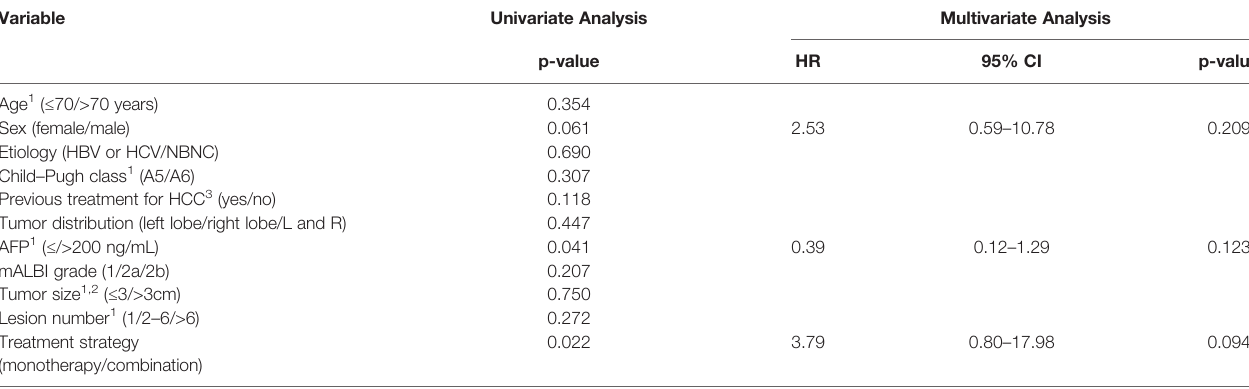
TABLE 4 | Univariate and multivariate analyses of factors associated with OS. Variable